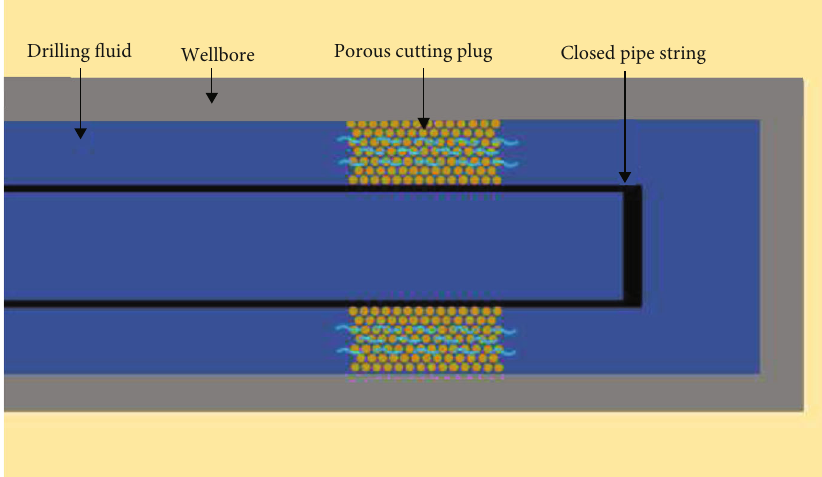
Figure 2: A closed pipe string with a porous cutting